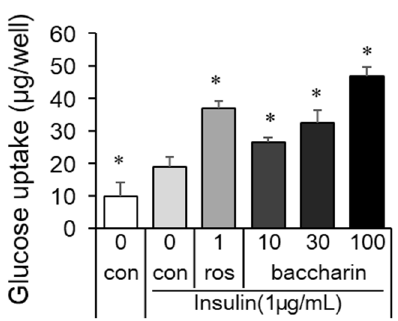
Figure 4. Effect of baccharin on glucose uptake in 3T3-L1 cells. In the presence of insulin (1 µg/mL), 3T3-L1 preadipocytes were cultured with rosiglitazone (1 µM) or baccharin (10–100 µM). The glucose concentrations in cultured medium were measured, and the differences before culture and after culture were calculated as glucose uptake. Values are expressed as means ± SEM ( n = 3). * p < 0.05 compared with the control in the presence of insulin. ros, rosiglitazone; con, control.